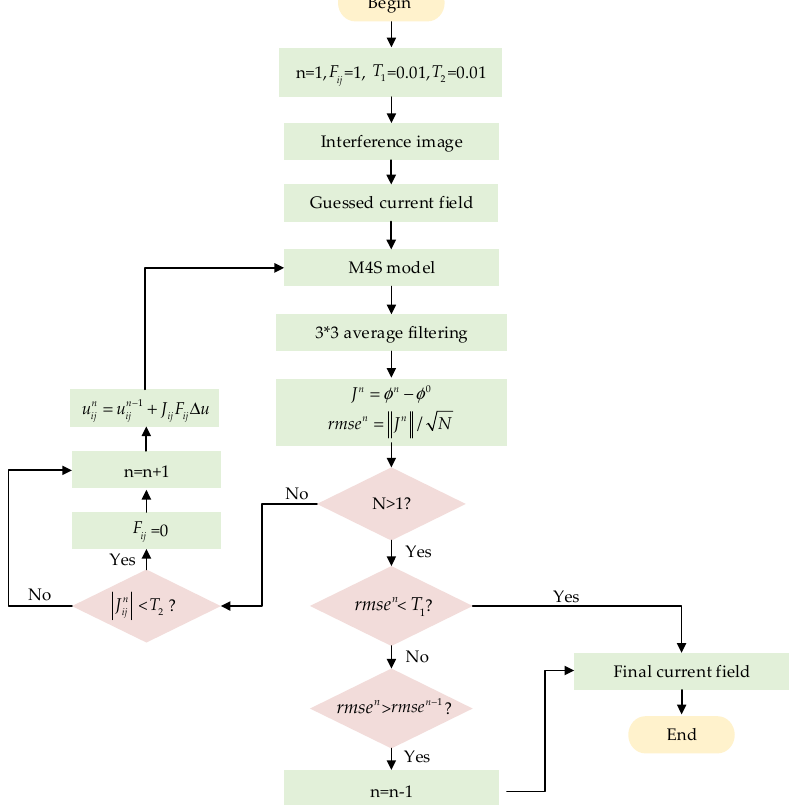
Figure 1. The flowchart of the iterative algorithm.